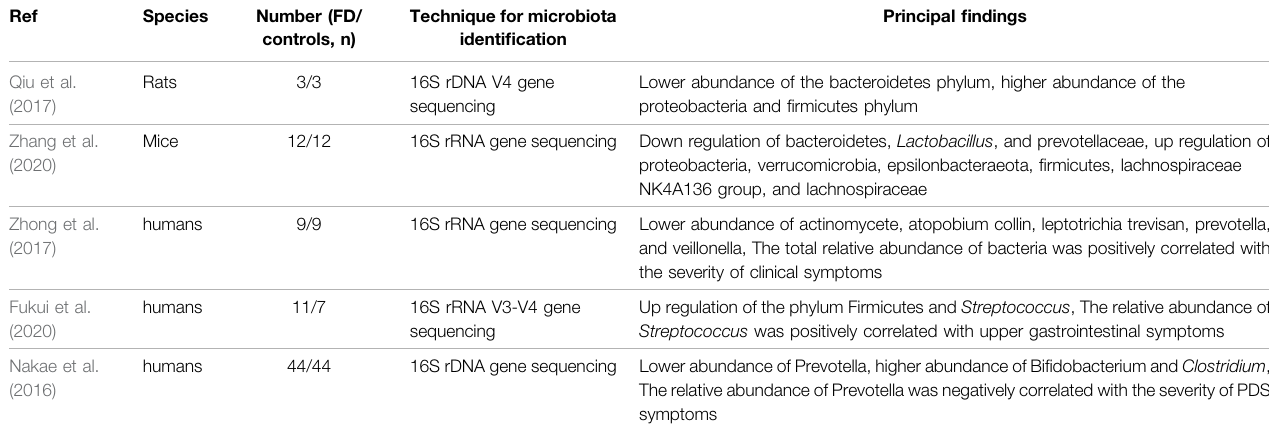
TABLE 1 | Gastrointestinal microbiome analysis studies in functional dyspepsia. Ref Species Number (FD/ controls,